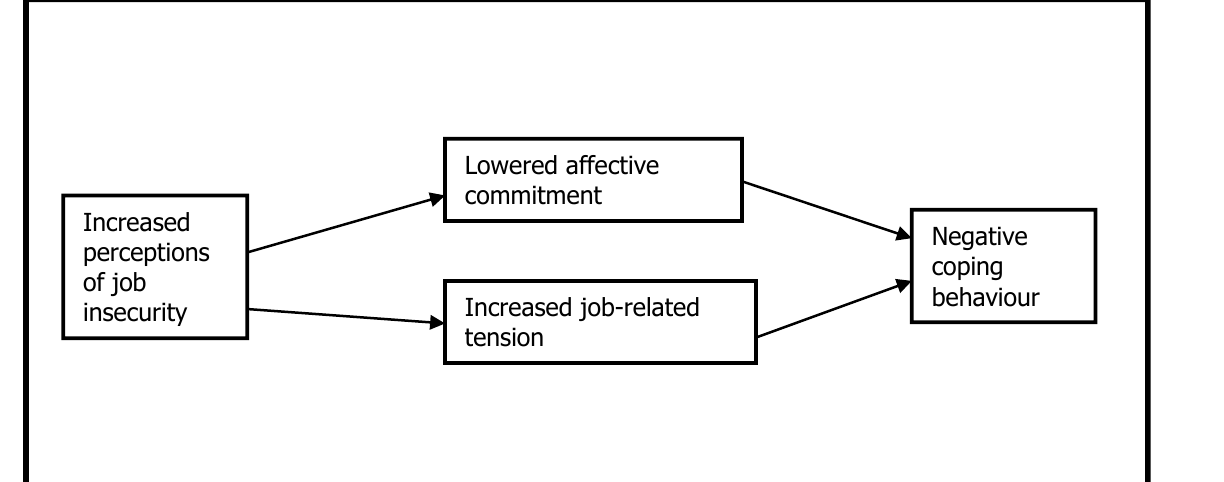
Figure 1. The first stage of the adapted theoretical model of Jordan, Ashkanasy and Härtel (2002: 362).